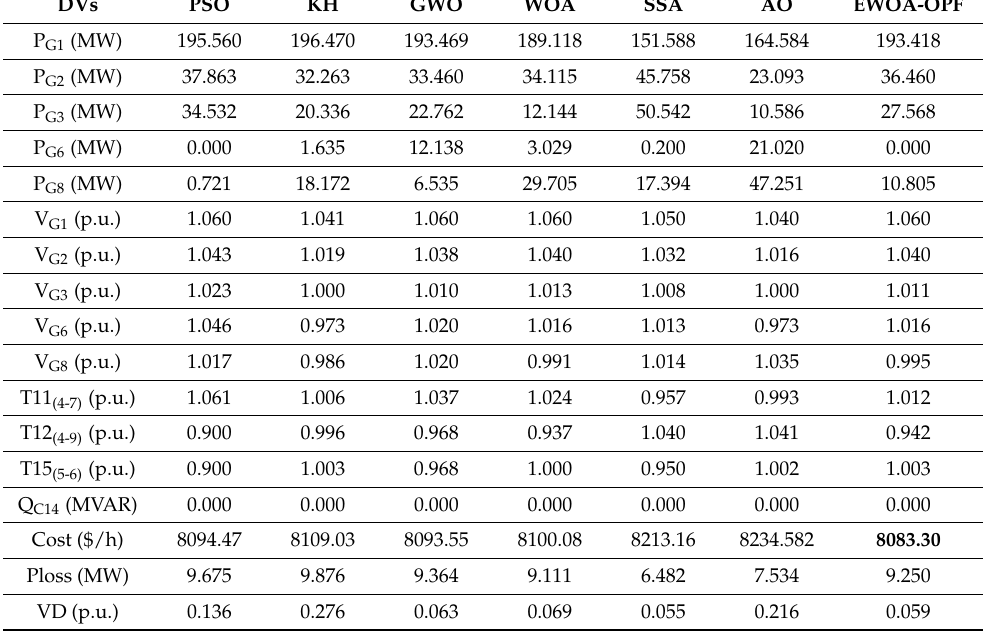
Table 5. Results of OPF for IEEE 14-bus test system on Case